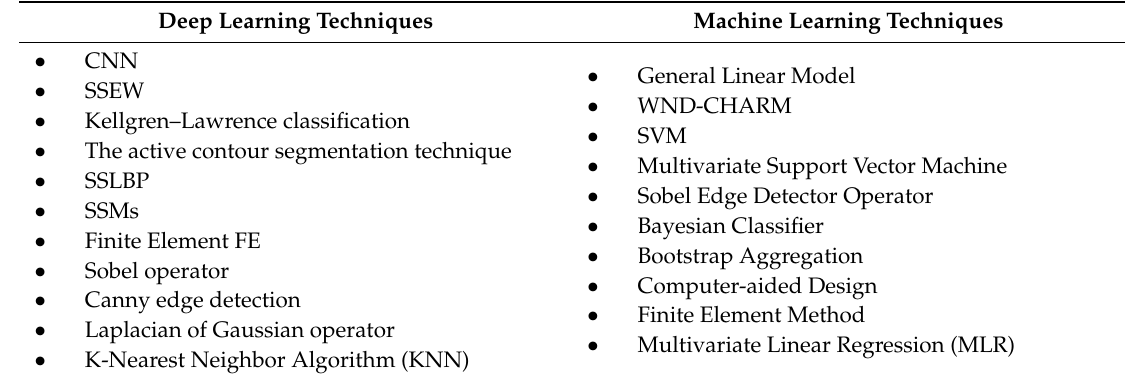
Table 15. Deep and machine learning